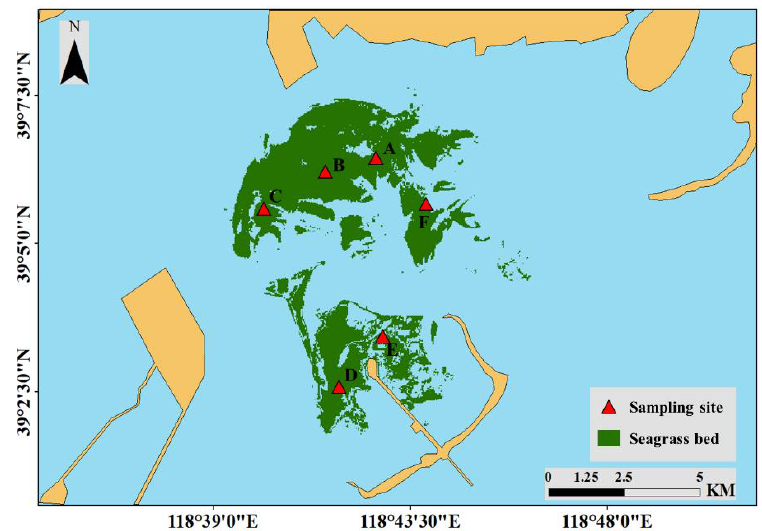
Figure 4. Field survey sites of eelgrass biological parameters in the study area. The red triangles ( A – F ) represent seagrass sampling sites.